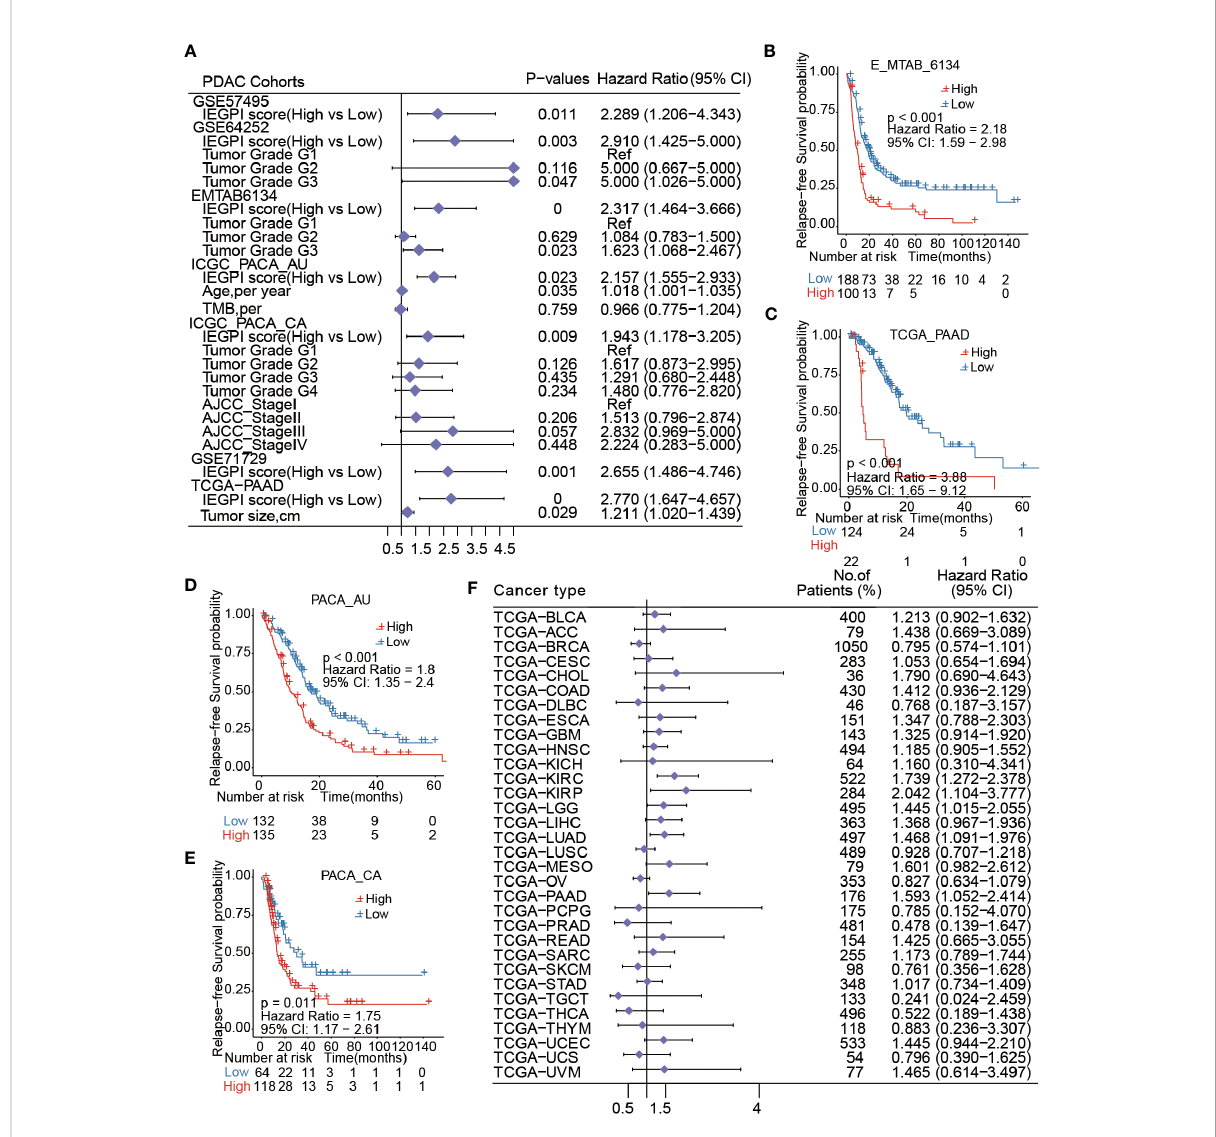
FIGURE 3 IEGPI score was an independent risk factor of OS in PDAC. (A) Multivariate Cox regression analysis results in seven PDAC datasets; (B – E) Kaplan-Meier curves of relapse-free survival in PDAC patients with different IEGPI score level in four public datasets; (F) the prognostic values of the IEGPI score in the Pan-cancer